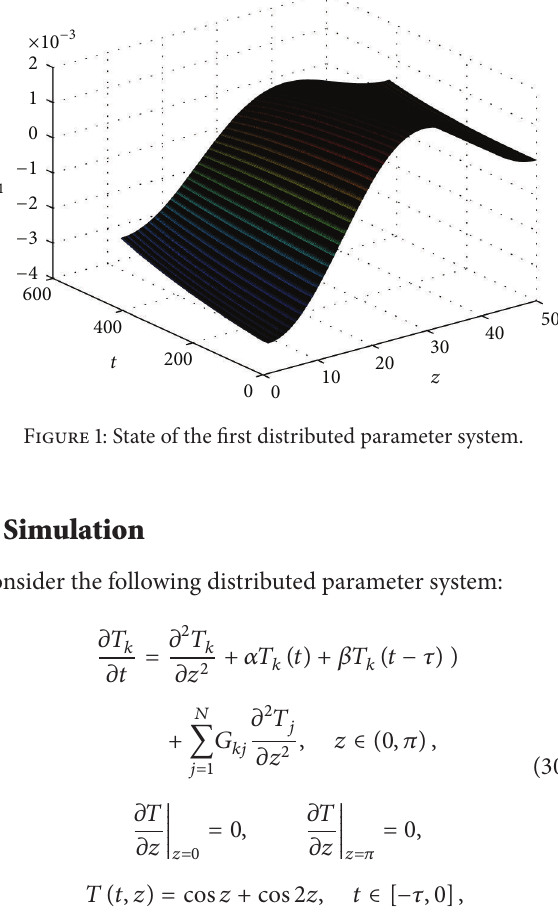
Figure 3: State of the third distributed parameter